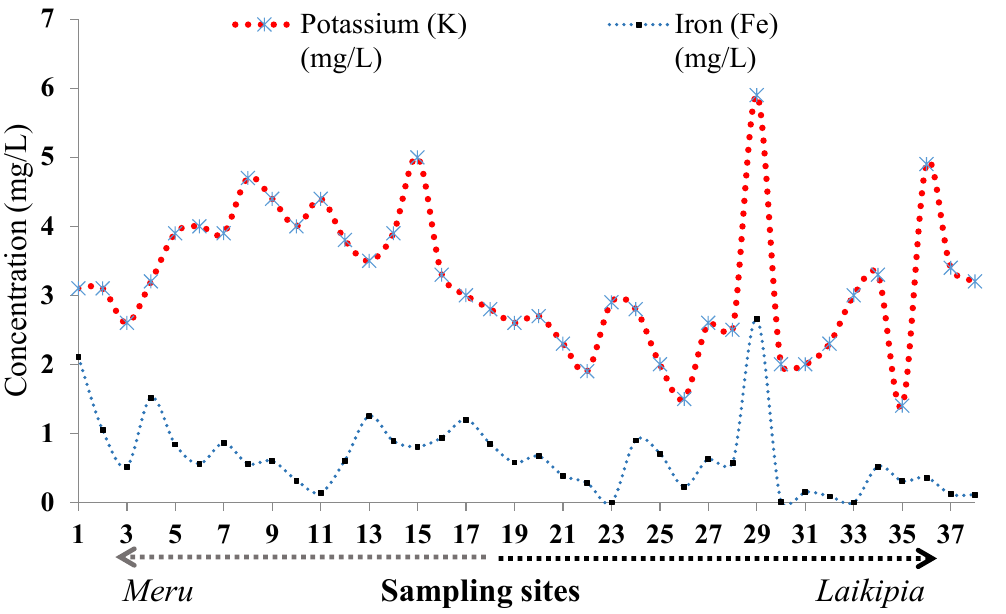
Figure 3. A scatterplot showing the spatial variation of potassium (mg/L) and iron (mg/L) across all 38 sampling sites in Meru (brown dotted line) and Laikipia (black dotted